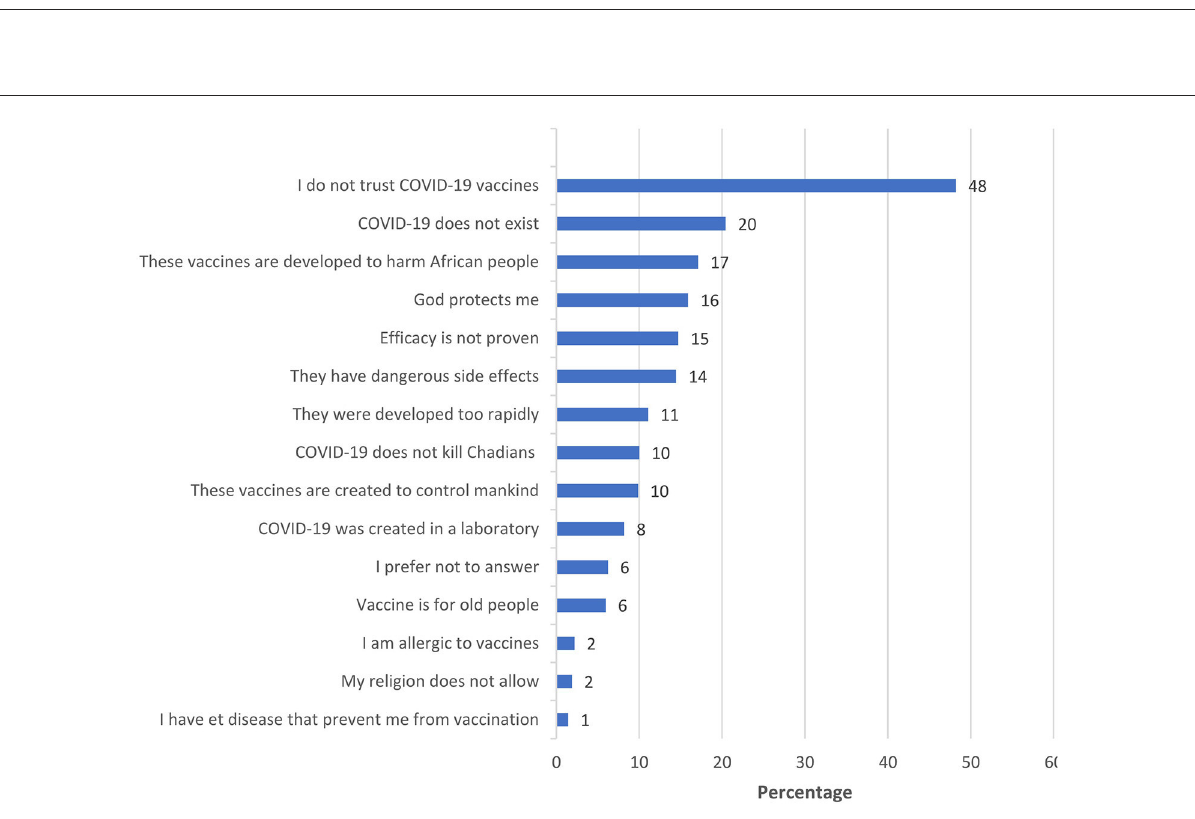
FIGURE2 Listed reasons for reluctance to be vaccinated against COVID-19, ranked in order of importance (in percent) among undecided or vaccine-refractory participants ( n =